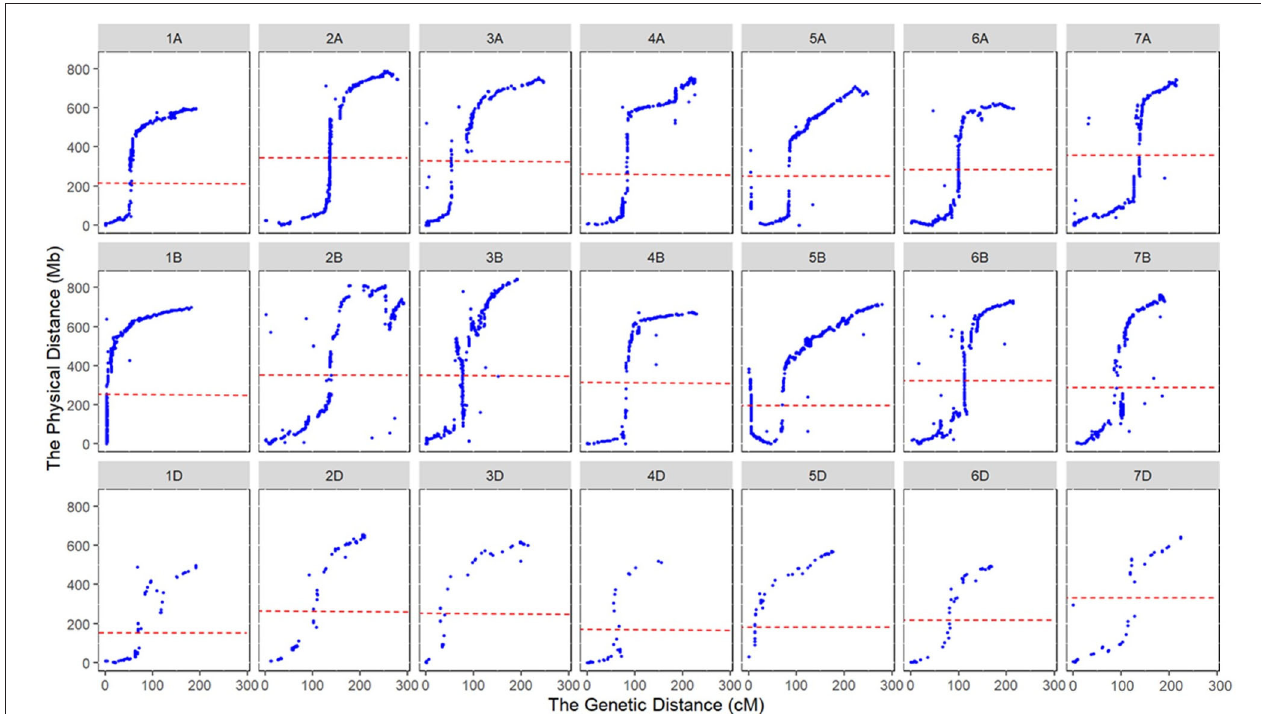
FIGURE 2 | Collinearity of marker orders between the consensus and physical maps. The dotted lines indicate the centromeres of chromosomes. but the number was much lower in the D genome, i.e.,